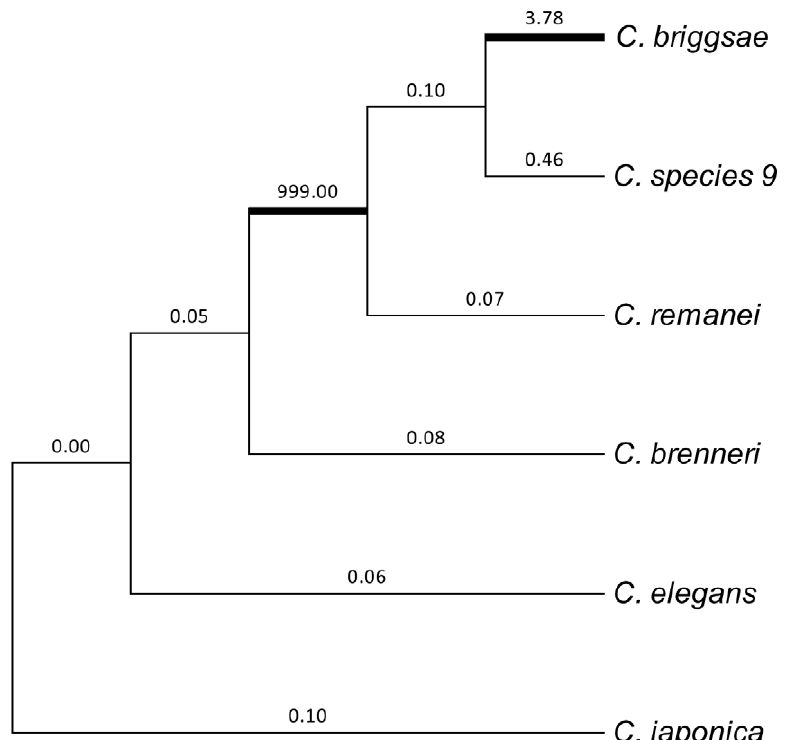
Figure 2. Neighbor-joinning tree of Caenorhabditis CENH3 HCP-3 gene. Bold branches indicate the lineages under positive selection. Numbers above branches are the v values. The value of v =999 indicates the branch for which